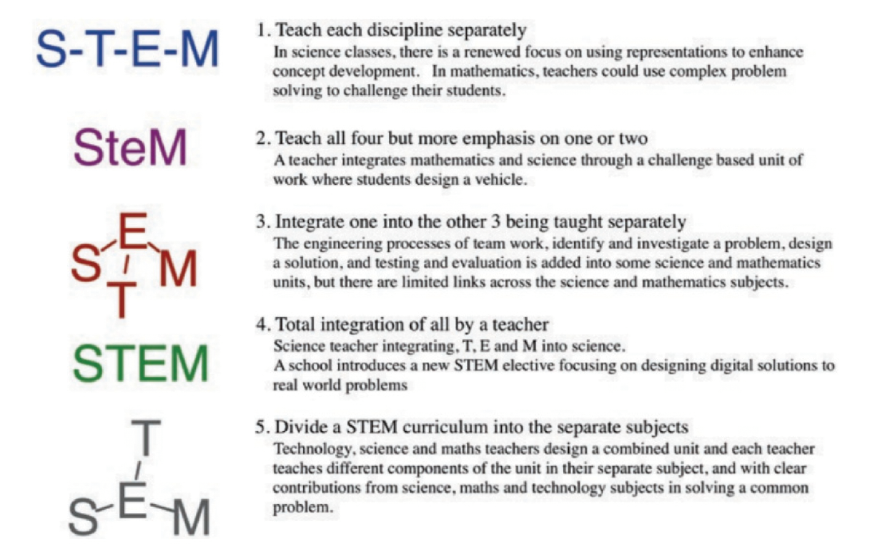
Figure 1. Models of STEM teaching according to Hobbs et al.